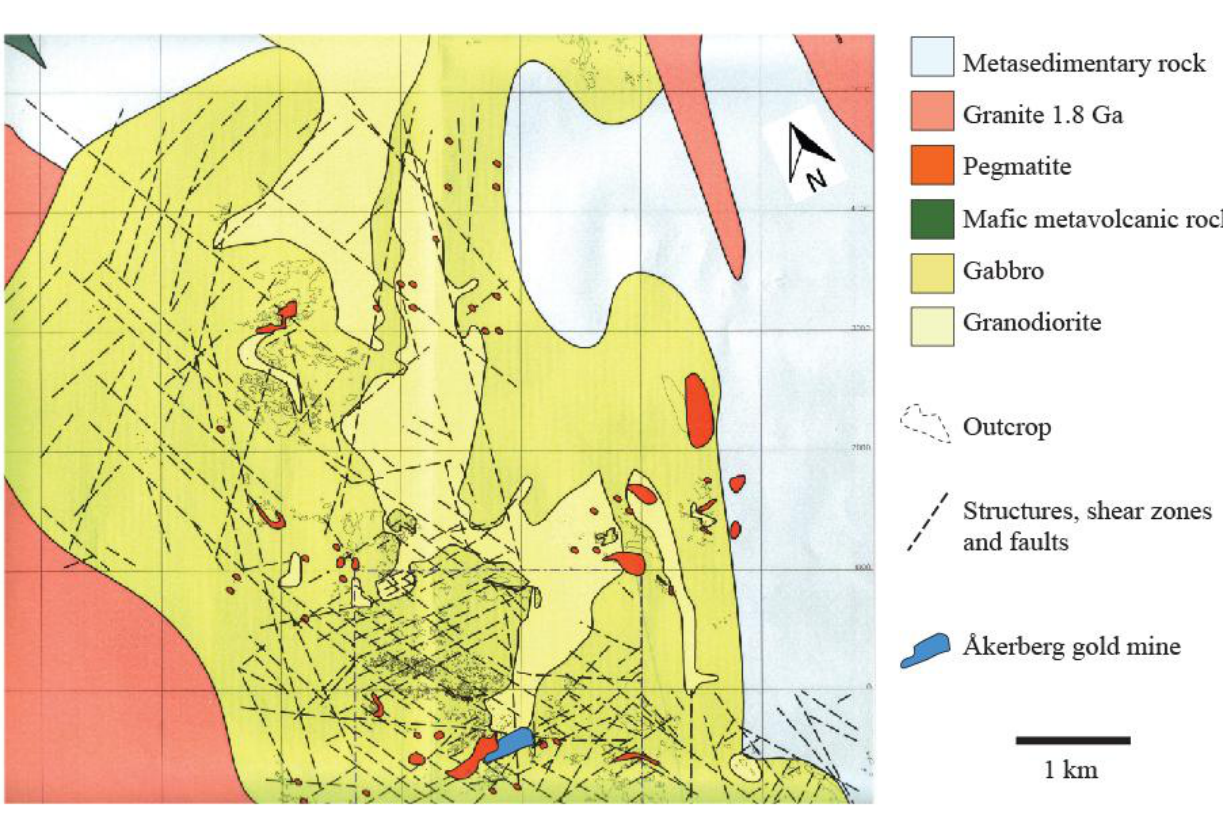
Figure 2. Geology of the Åkerberg area (modified after Mattson and Lundstam [23]). The two gabbro rock specimens and the granodiorite selected for dating were taken from localities in a limited area just north of the gold mine. A locally used grid is shown on the map. The center of the outlined gold mine corresponds approximately to coordinates N722455 and E173250 in the Swedish National Grid,